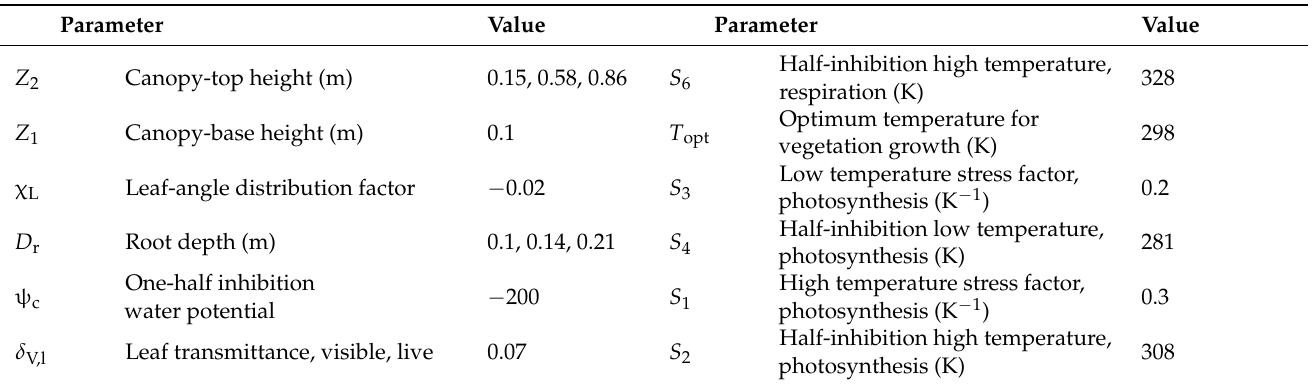
Table A1. Parameter settings in the SiB2 model for